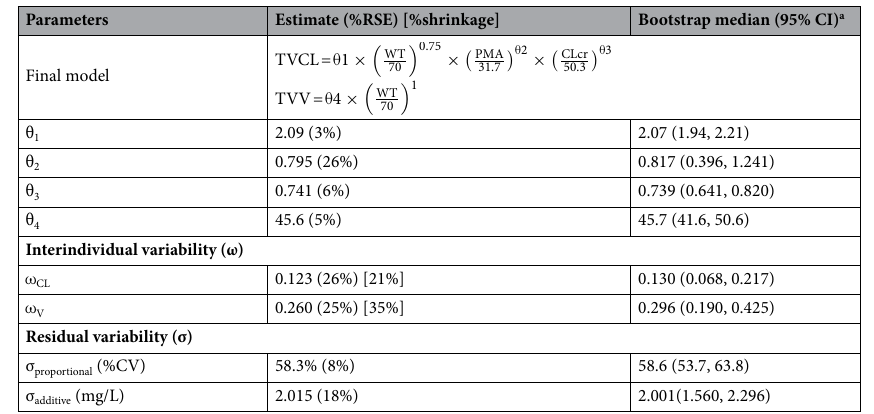
Table 2. Final population pharmacokinetics model parameters for vancomycin in neonates. a 95% CI estimated from 1000 resampled data sets using the final population (993 successful run). TVCL typical value of clearance (L/h), TVV typical value of volume of distribution (L), CLcr creatinine clearance (calculated by the Schwartz equation), PMA postmenstrual age, WT body weight, ω CL interindividual variability of clearance, ω v interindividual variability of volume of distribution, σ proportional proportional residual error, σ additive additive residual